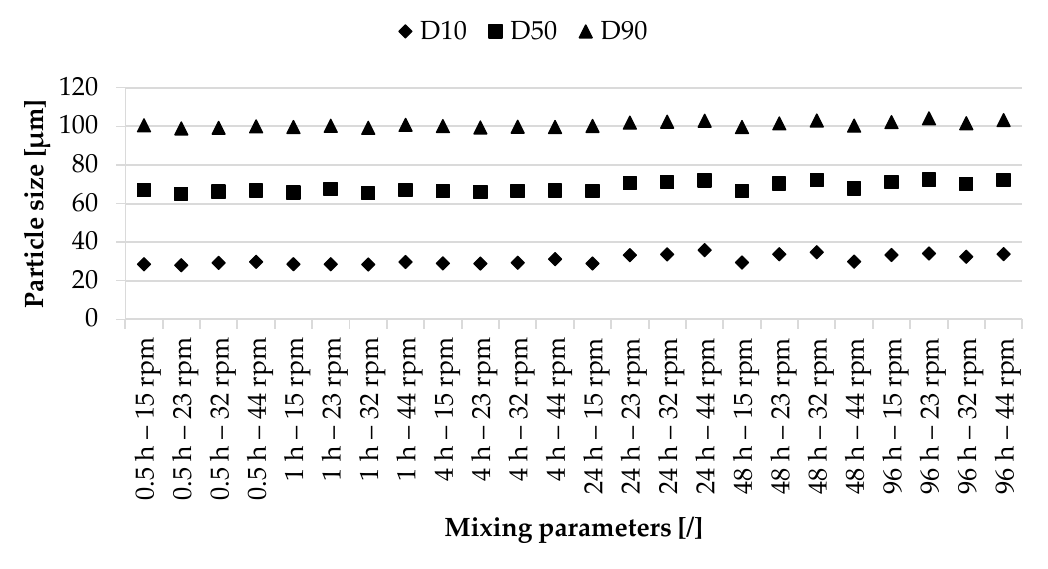
Figure 5. Influence of the mixing process on the characteristic values of the particle size distribution. Six mixing durations with four mixing intensities in each case are considered. Determined with Camsizer XT.